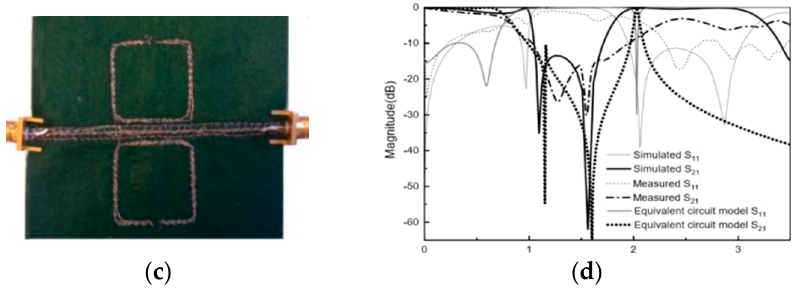
Figure 5. ( a ) Layout of transmission line loaded with symmetrical SRRs. ( b ) Lumped element circuit model. ( c ) Photograph of the embroidered design. ( d ) S-parameter responses of the EM simulation, equivalent circuit model, and measurement of embroidered transmission line loaded with two symmetric SRRs.